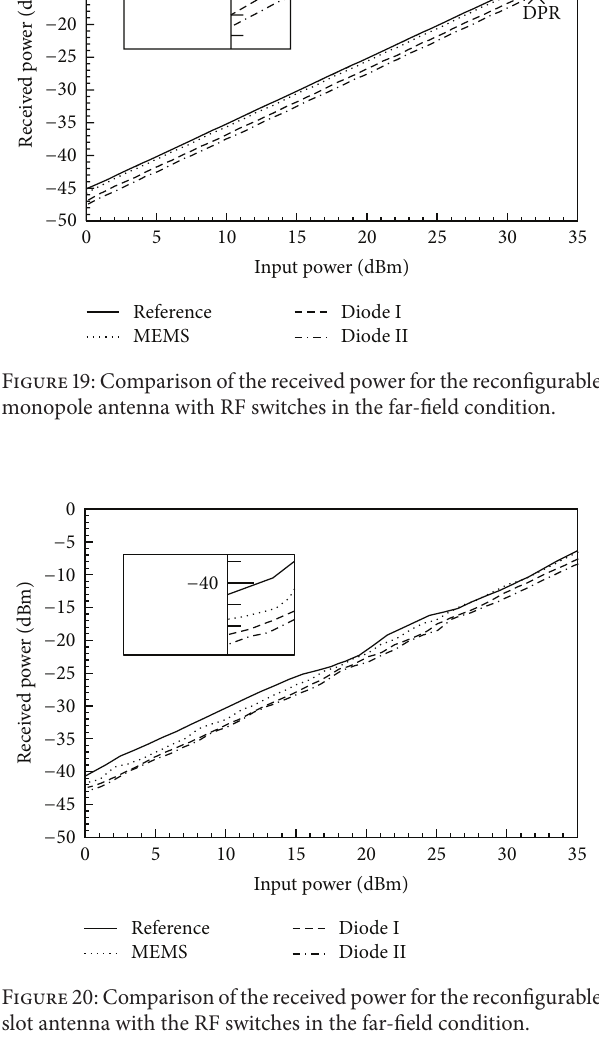
and the maximum power rating of the RF switches.